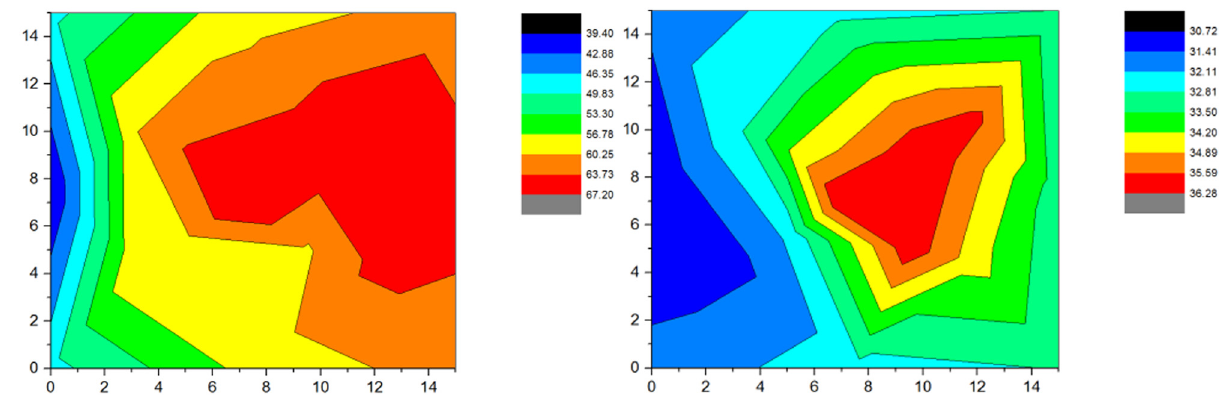
Figure 6: Temperature fi eld distribution of low - thermal asphalt sample at 200 and 600 s.